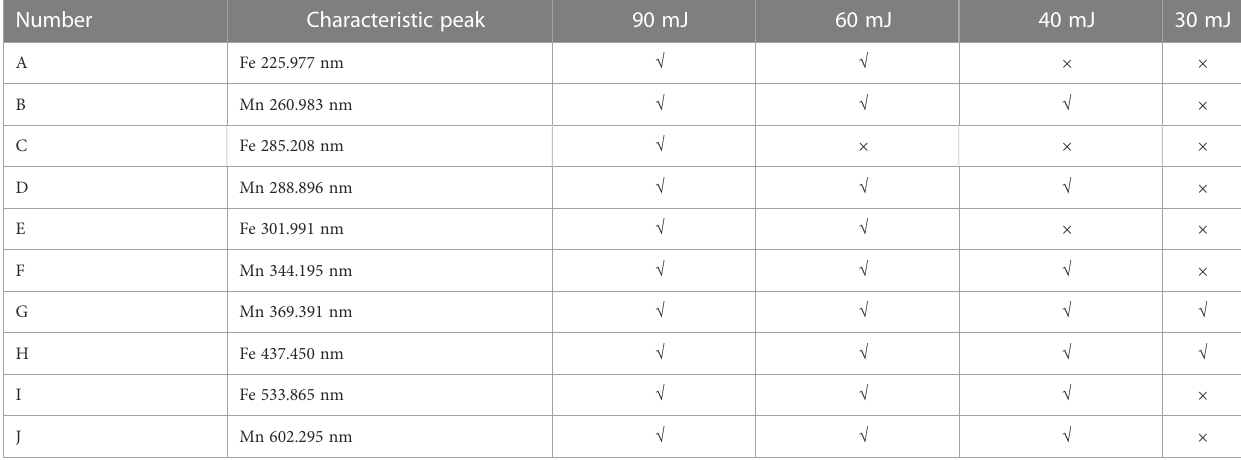
TABLE 1 Characteristic peaks of Fe, Mn, and Co at a laser energy of 30 – 90